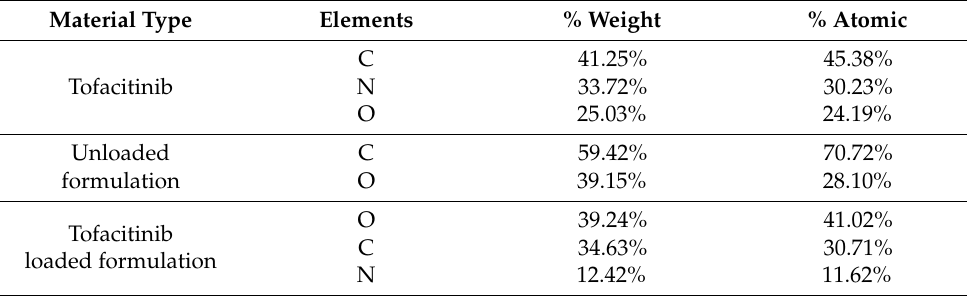
Table 1. Elemental composition of tofacitinib, loaded, and unloaded formulations.